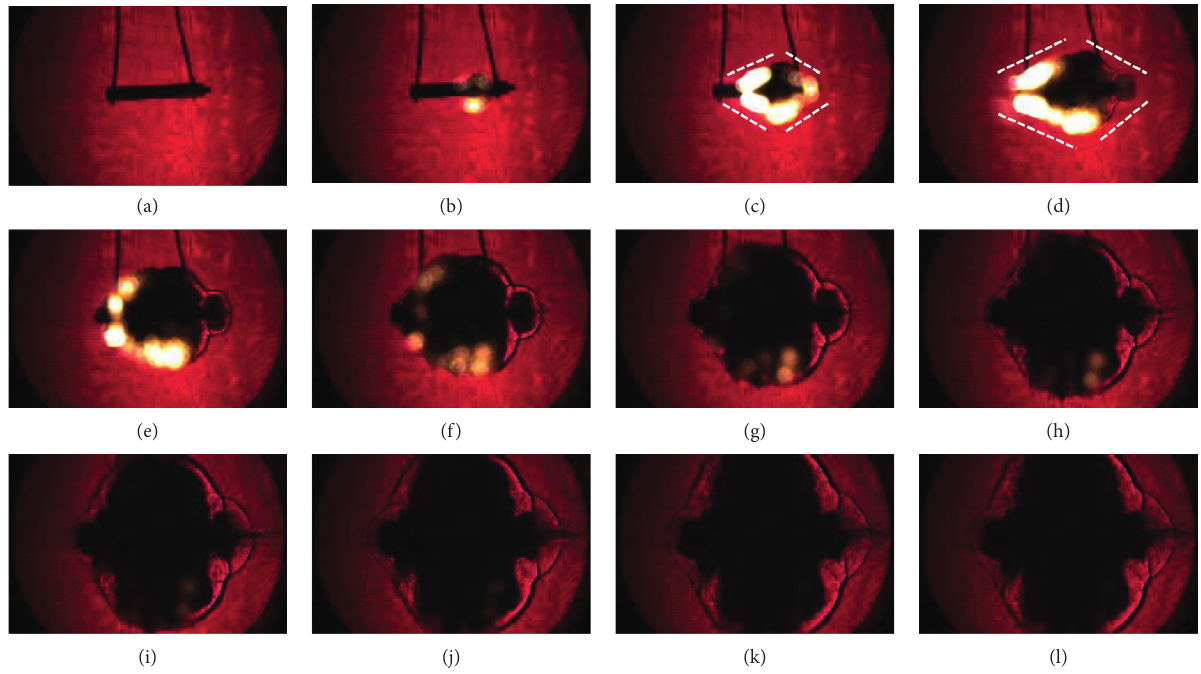
Figure 5: High-speed schlieren images for perpendicular orientation of the charge (perpendicular to laser light). (a) 0 μ s, (b) 10 μ s, (c) 20 μ